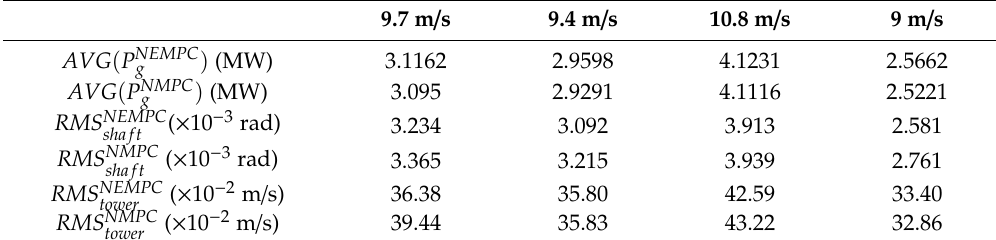
Table 2. Data analysis based on the results in Figure 11.